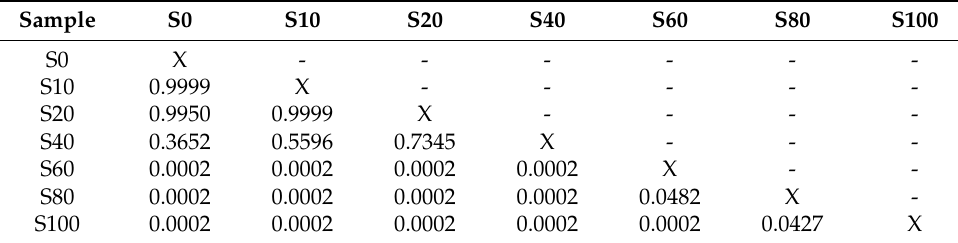
Table A1. Post-hoc analysis by Tukey’s test of the hysteresis area values.